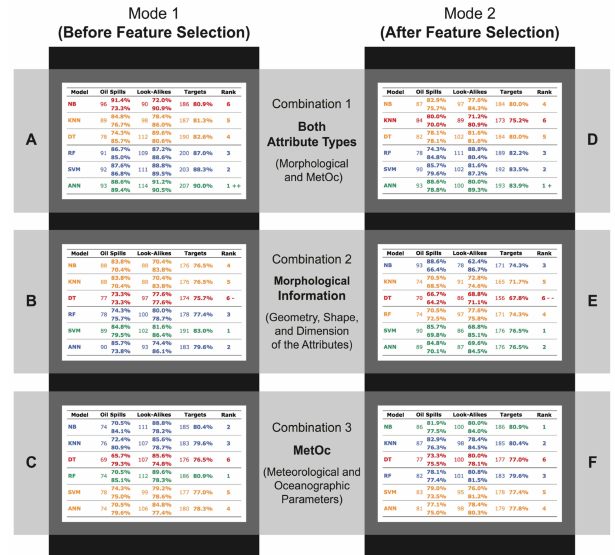
Figure 6. Classification-accuracy assessment of the 36 data-driven machine-learning (ML) classi- fication algorithms derived from the first three stages of our experiment: (i) two feature-selection modes (before (Mode 1) and after (Mode 2) feature selection—Section 2.1.1); (ii) three combinations of variables (both attribute types together (Combination 1: morphological and MetOc), geometry, shape, and dimension attributes (Combination 2: morphological information), and Meteorological and Oceanographic Parameters (Combination 3: MetOc)—Section 2.1.2); and (iii) six ML methods (naive Bayes (NB), K-nearest neighbor (KNN), decision trees (DT), random forest (RF), support vector machine (SVM), artificial neural network (ANN)—Section 2.1.3). The six white boxes ( A , B , C , D , E , and F ), the two vertical black boxes (( A , B , and C ) and ( D , E , and F )), and the three horizontal gray boxes (( A and B ), ( B and E ), and ( C and F )) are visually aligned with the three comparison levels and six variable sets depicted in Figures 2 and 5. See Figure 4 for information about overall accuracy, sensitivity, specificity, and predictive values (positive and negative). Green: the most effective algorithm (1st). Blue: 2nd and 3rd ranks. Orange: 4th and 5th ranks. Red: the least accurate algorithm (6th). Symbols: best and worst of all 36 algorithms (++ and −− ) and best and worst algorithms of each feature-selection mode (+ and − ). See Figure 7 and Section 3.3.